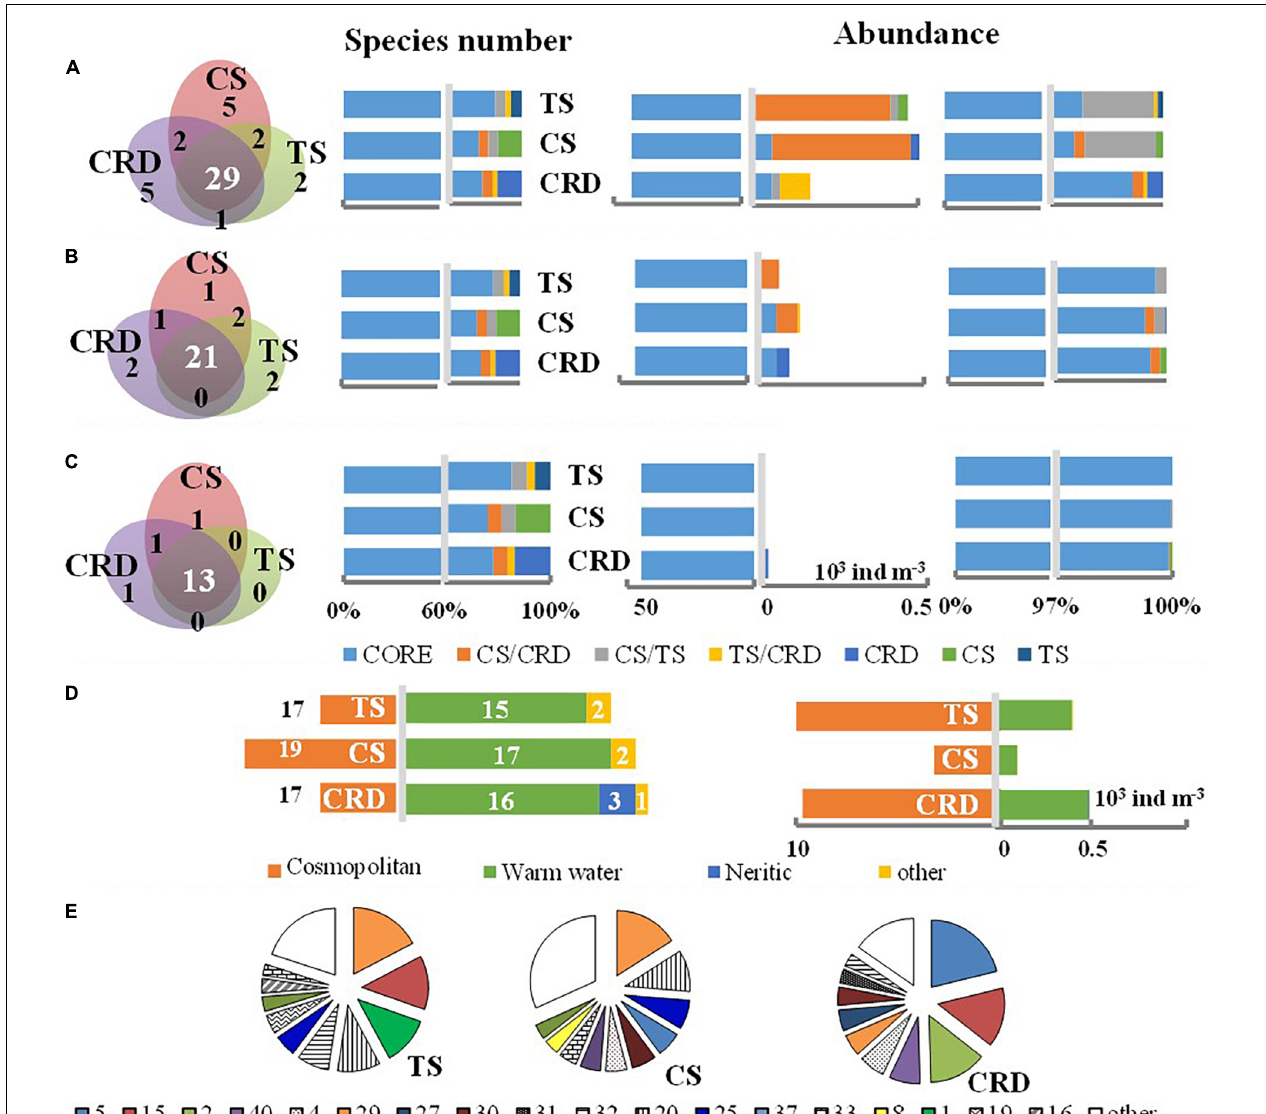
FIGURE 3 | Comparisons of the taxonomic composition of tintinnid assemblages in terms of species (A) , genera (B) , LOD size-class (C) , biogeographic patterns (D) , and abundant species (E) in the CRD, CS, and TS, with consideration of species richness and abundances. Core (CORE), common (CS/CRD, CS/TS, and TS/CRD), and endemic species (CRD, CS, and TS) are shown in Panels (A–C) . The abundance percentages of the first 10 abundant species are shown in Panel (E) . Species numbers are shown in Table 1